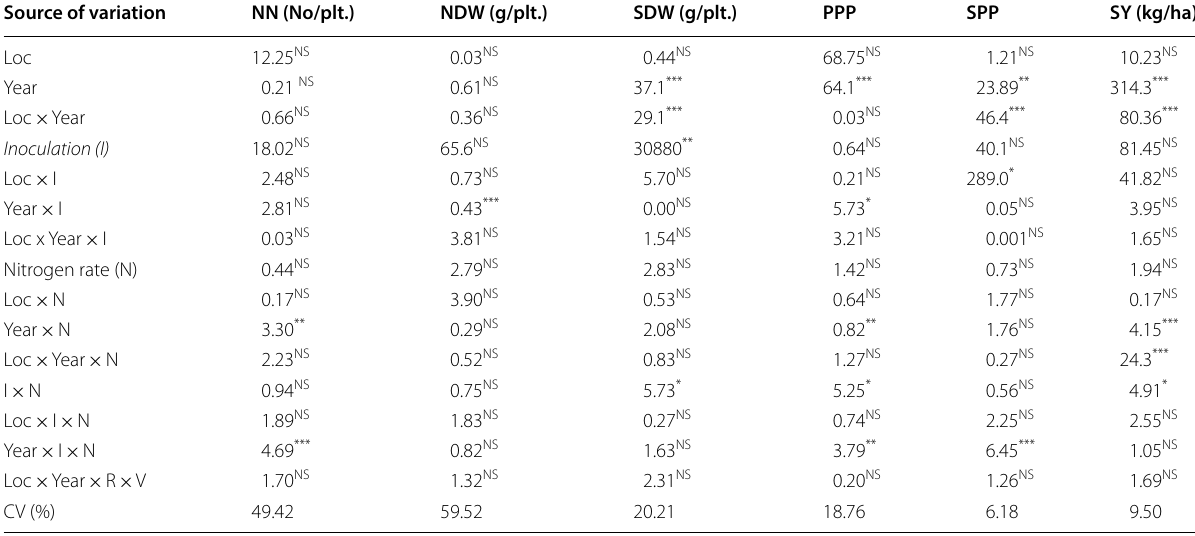
NN, nodule number; NDW, nodule dry weight; SDW, shoot dry weight; PPP, pod per plant; SPP, seed per pod; SY, seed yield, NS, non-significant (p > 0.05) *significant (p < 0.05), **highly significant (p < 0.001), ***extremly significant (p < 0.0001)